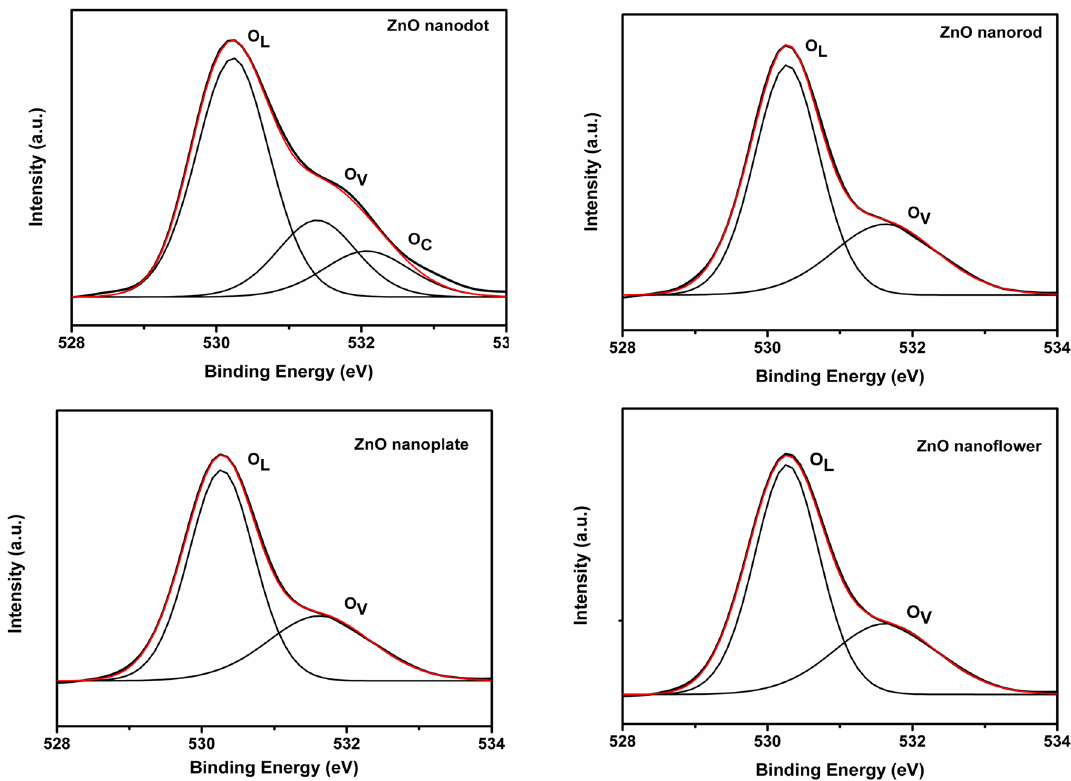
Figure 8. XPS spectra of ZnO nanostructures synthesized in distinct